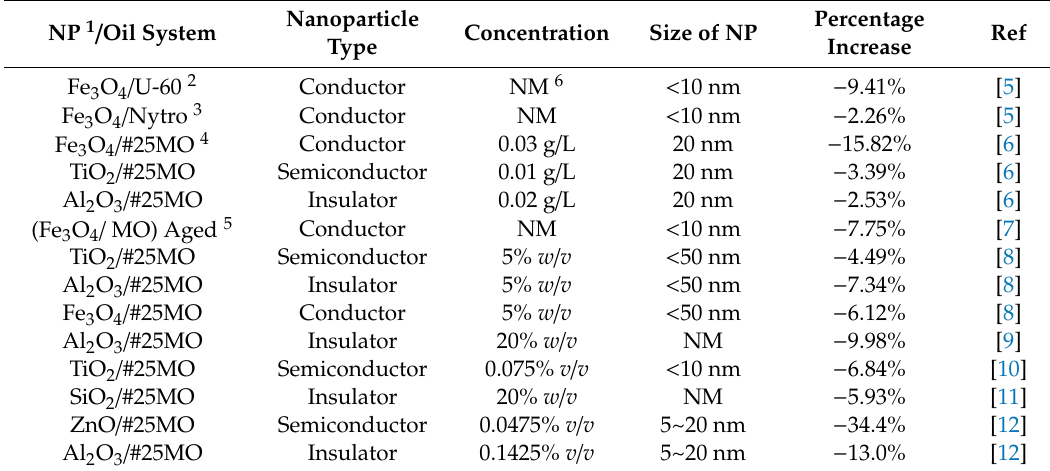
Table 1. Reduction of negative lightning impulse breakdown voltage of nano-insulating oil relative to host oil reported in the literature.